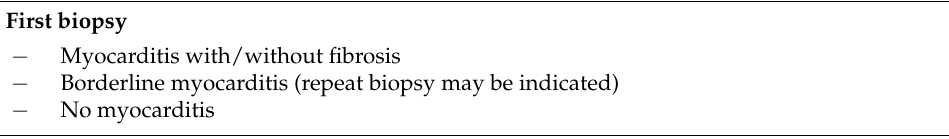
Table A1. The Dallas criteria for myocarditis. Definition: An inflammatory infiltrate of the myocardium with necrosis and/or degeneration of adjacent myocytes not typical of the ischemic damage associated with coronary artery